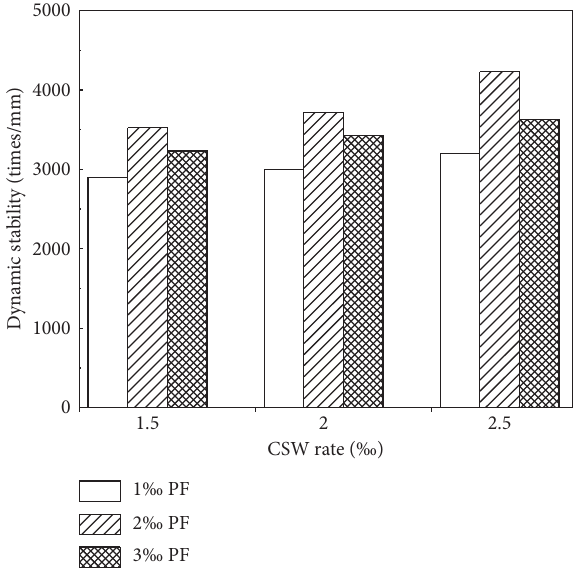
Figure 1: Comparison of dynamic stability values for different polyester fiber amounts and for certain calcium sulfate whisker rates.